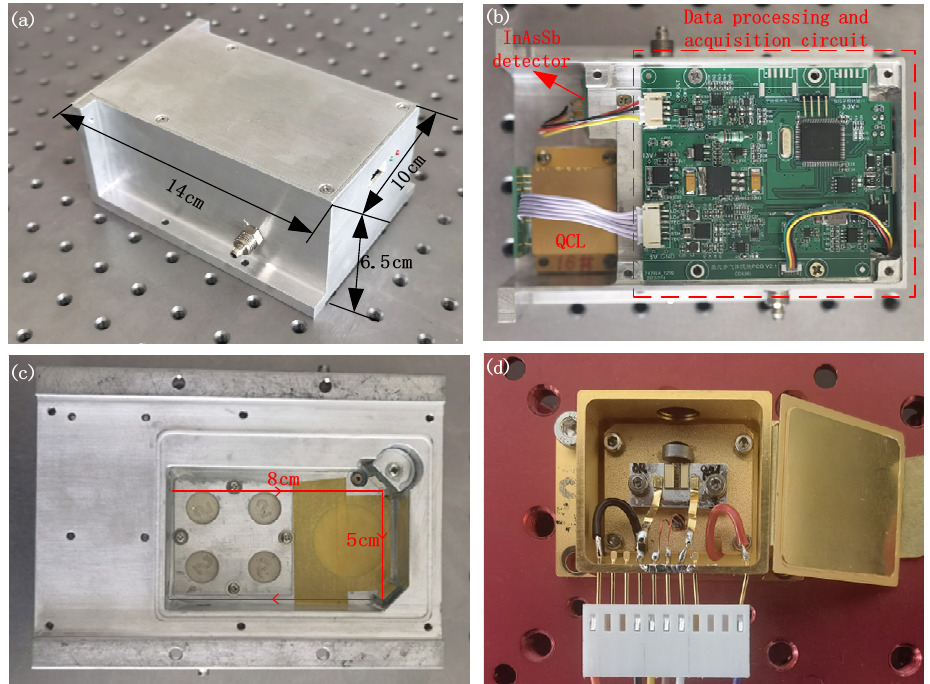
Figure 3. Photographs of ( a ) the compact and low-power-consumption CO sensor; ( b ) internal structure of the CO sensor; ( c ) small gas cell, located on the back of CO sensor; and ( d ) the QCL.